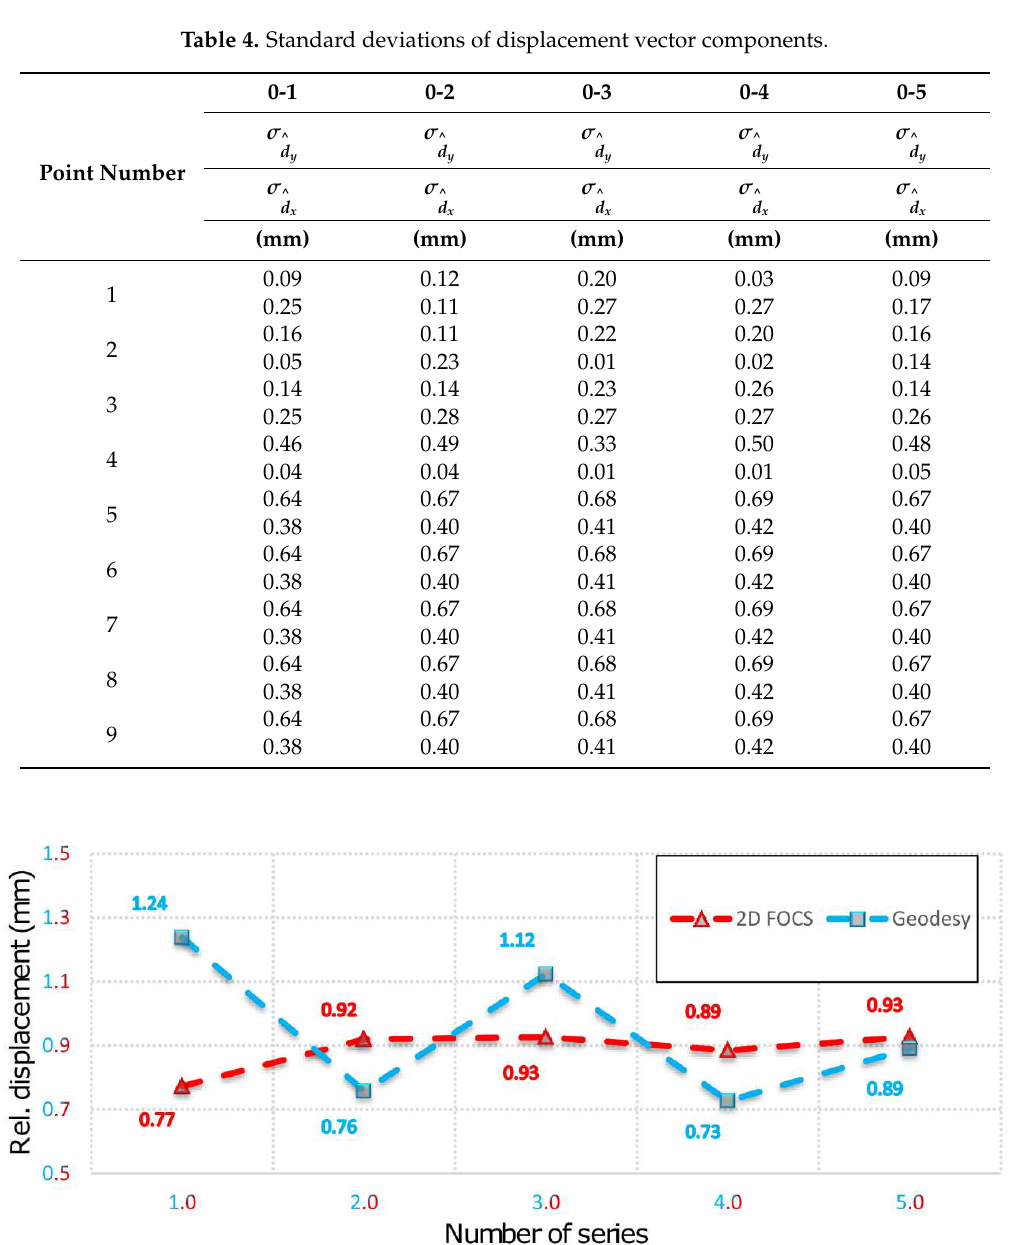
2D deflection sensor. This event is result of the fact that during the action of the PTP the beam was